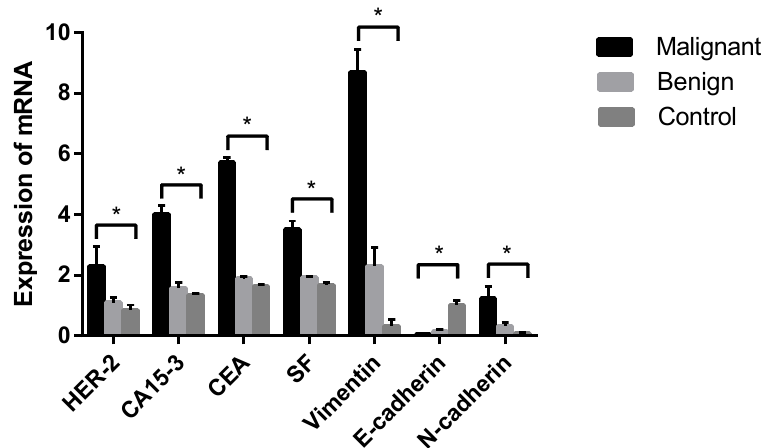
Figure 5. Comparison of HER-2, CA15-3, CEA, SF, Vimentin, E-cadherin and N-cadherin mRNA in each group. Note: Control means tumor-adjacent healthy tissues. Highly significant ( p < 0.05) as indicated by